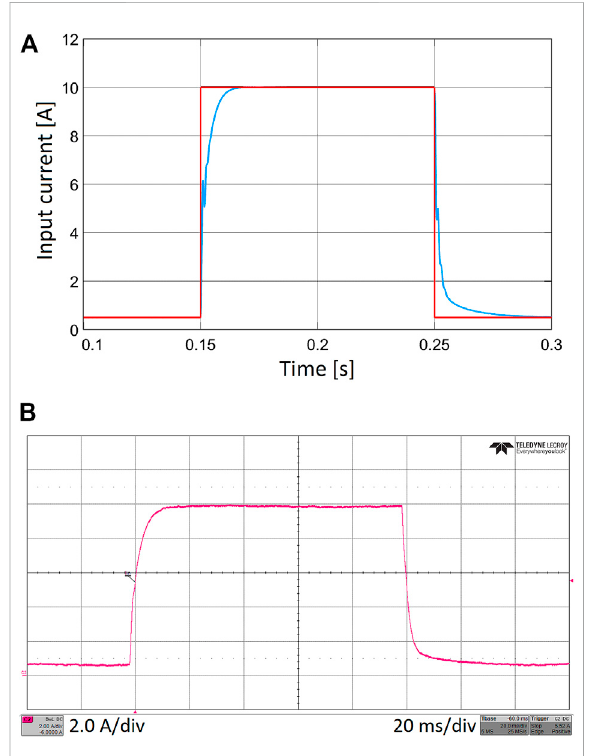
FIGURE 12 Simulation (A) end experimental (B) results of current step